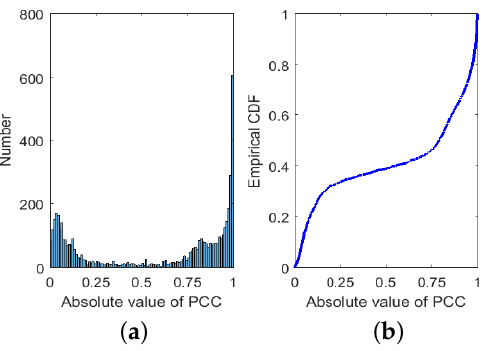
Figure 1. Histogram ( a ) and empirical CDF ( b ) of the absolute value of PCCs between different